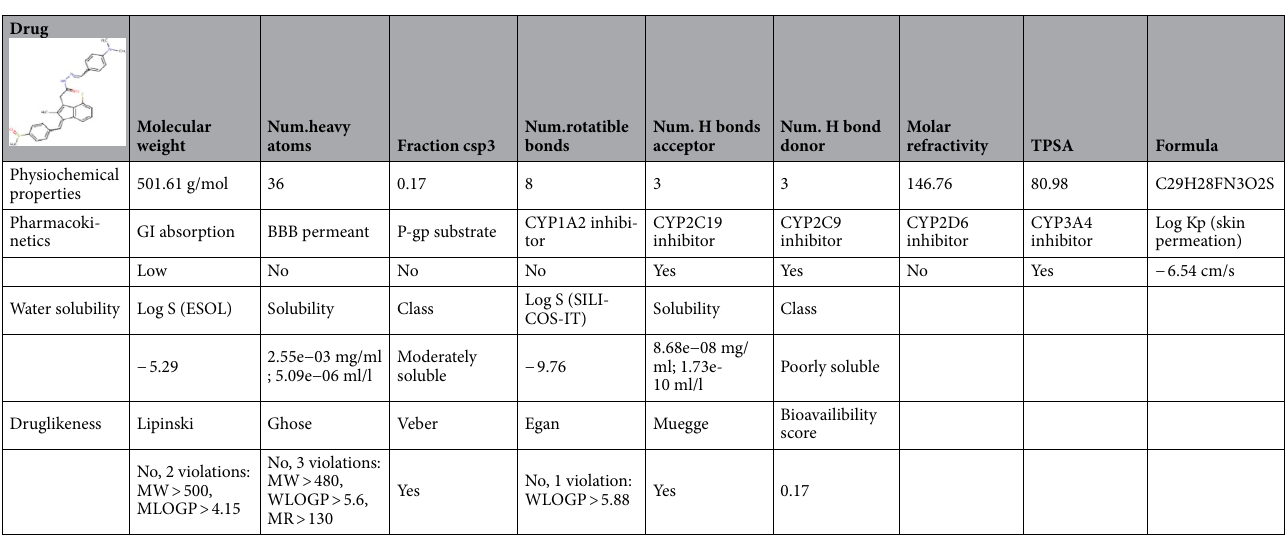
Table 6. Molecular descriptors of DMFM through insilico QSAR